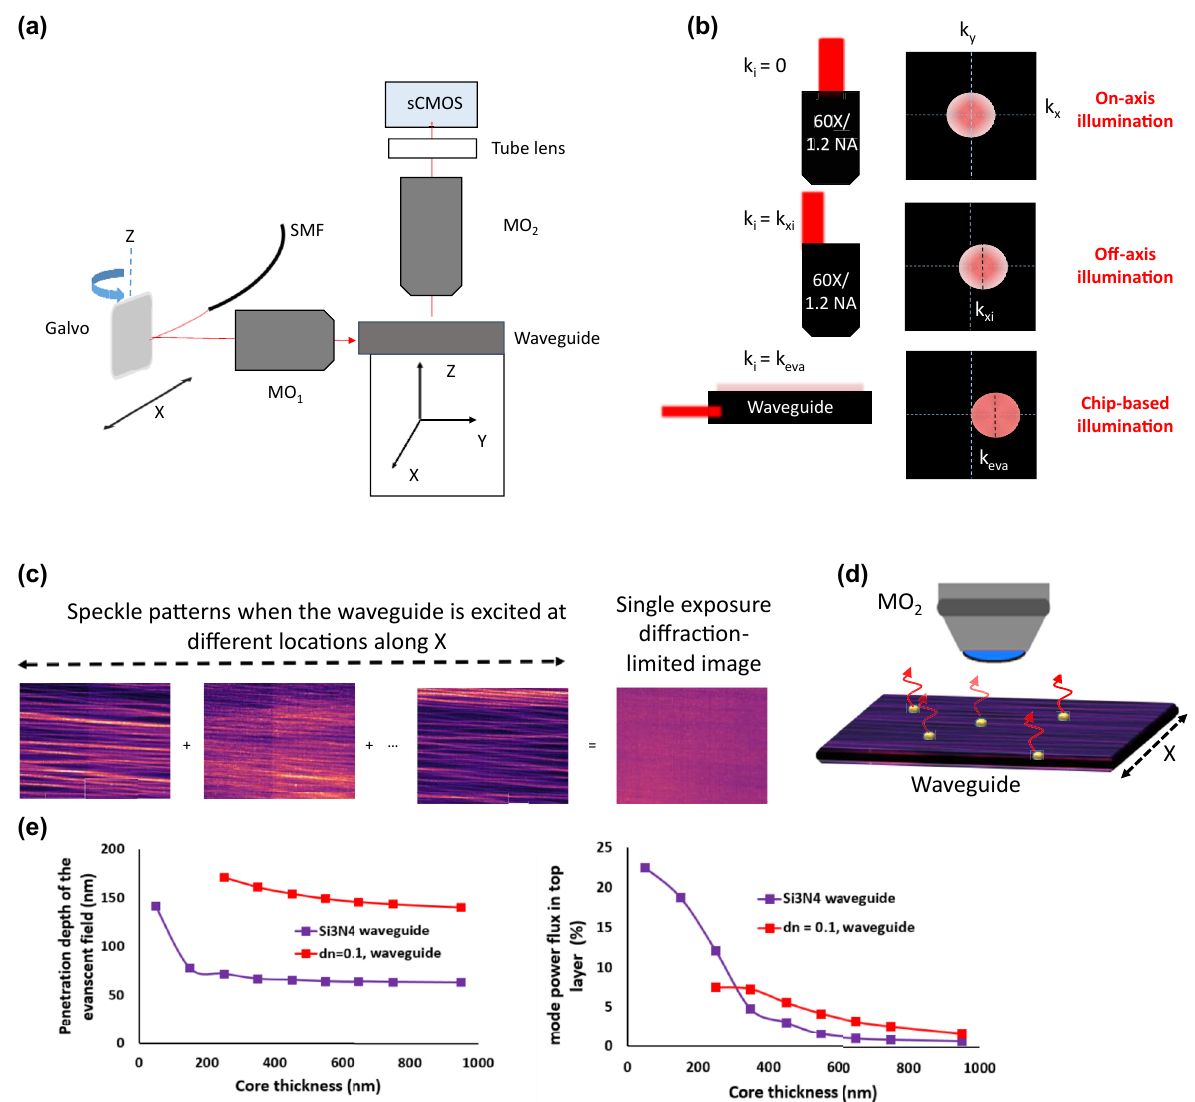
Figure 1: Basic concepts of cELS. (a) Schematic of cELS experimental setup. (b) Influence of obliquity of illumination in Fourier domain ( k corresponding to on-axis epi-illumination ( k the corresponding object spectrum they sample are shown. Flat-field like illumination provided by high-refractive index chip provides access to the higher sample spatial frequencies. (c) The addition of multiple speckle patterns at the camera plane helps suppress the speckle noise. (d) Schematic representation of an optical waveguide supporting several guided modes and some scattering objects that convert the evanescent waves into scattering waves is also given. (e) The penetration depth and field intensity of a TE1 mode of Si ( Δ n ≈ 0.5) waveguide and an index matched waveguide ( Δ n ≈ 0.1) are provided